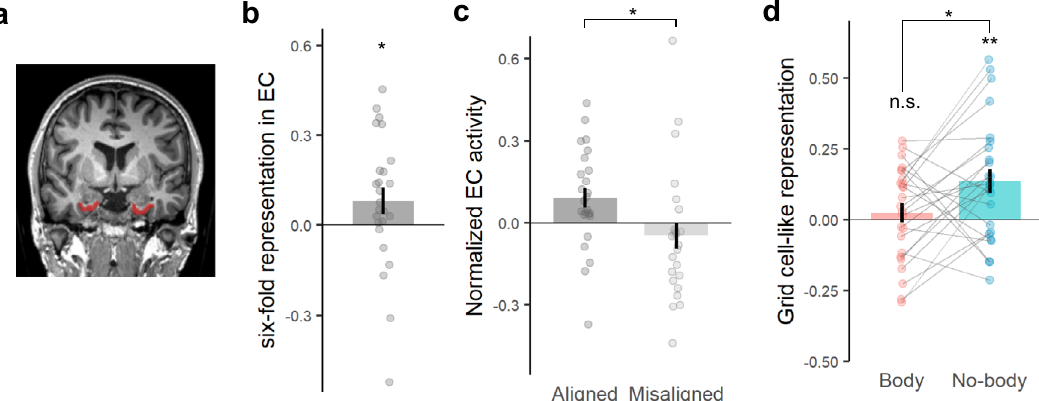
Fig. 3 Decrease of entorhinal grid cell-like representation in the Body condition. a EC ROI of an exemplary participant b Signi fi cant sixfold symmetric grid cell-like representation (GCLR) in human entorhinal cortex (EC), calculated for the entire recording session regardless of the experimental condition ( n = 25; p = 0.0128). c EC activity during aligned navigation was signi fi cantly higher than during misaligned navigation ( n = 25; p = 0.0226). d Condition- wise GCLRs were signi fi cantly higher in the No-body (standard spatial navigation condition) than the Body condition ( n = 25; p = 0.0236). Notably, condition-wise grid cell-like representations in the Body condition were not signi fi cantly greater than zero (Body: p = 0.245, No-body: p = 2.30e-03), implying that the difference between conditions can be attributed to a reduced GCLR in the Body condition. n.s.: p > = 0.05, *0.01< = p < 0.05, ** p < 0.01. Each error bar indicates a standard